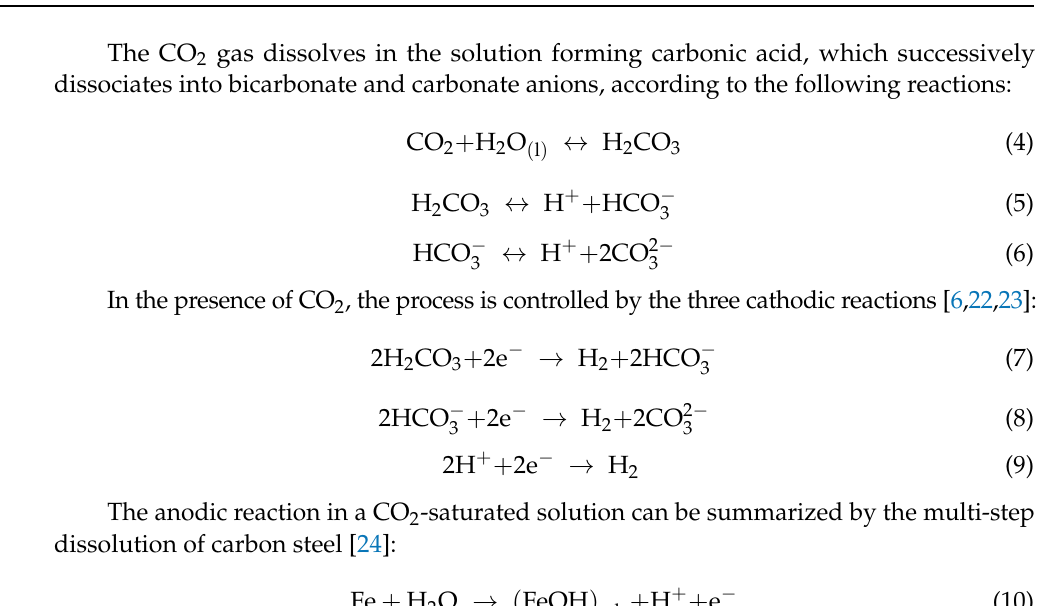
Table 4. Electrochemical impedance parameters of the two steels in the tested solution after the IR drop correction.